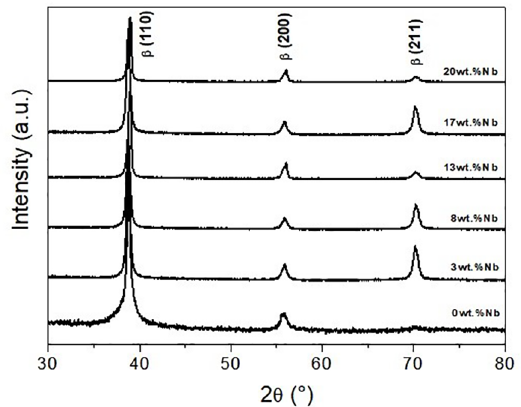
Figure 1. XRD of the as–cast Ti-12Mo-xNb alloys Figure 2 shows different OM of the as-cast Ti-12Mo- xNb alloys. The micrographs showed the presence of single β phase matrix and the formation of dendrites in the grains due to the lack of homogenization of the chemical elements that make up the alloys caused by the secondary solidification process, being one of the characteristics of the as-cast alloys 23 . Moreover, it was observed that the niobium addition carried in refined